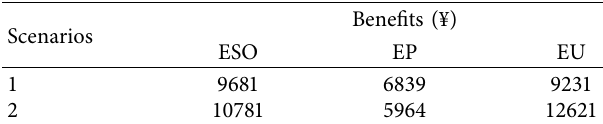
Table 7: Te comparison of income of each player under diferent scenarios. Scenarios